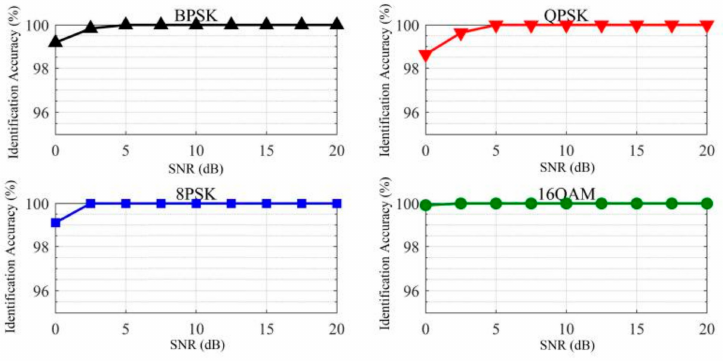
Figure 7. Identification accuracy curves of four modulation formats in free-space